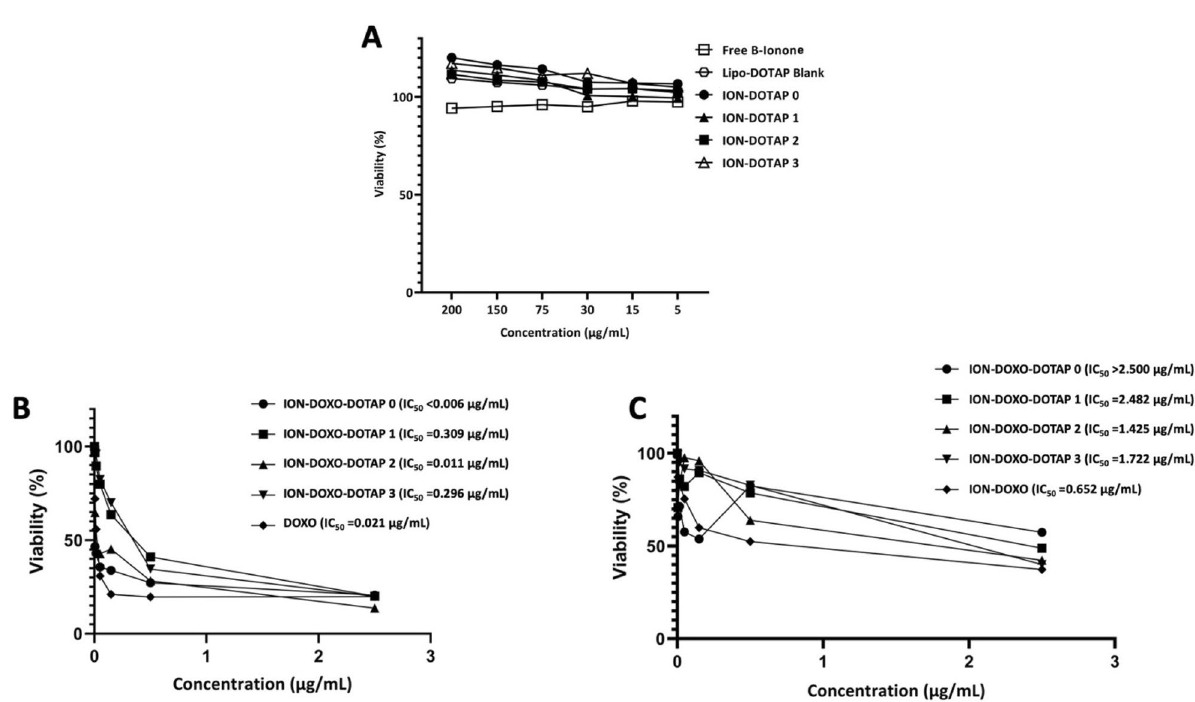
Figure 9. The viability of ( A ) HeLa cells after incubation of β-ionone liposomes and ( B ) T47D and ( C ) HeLa cells after incubation with β-ionone liposomes co-loaded with doxorubicin for 48